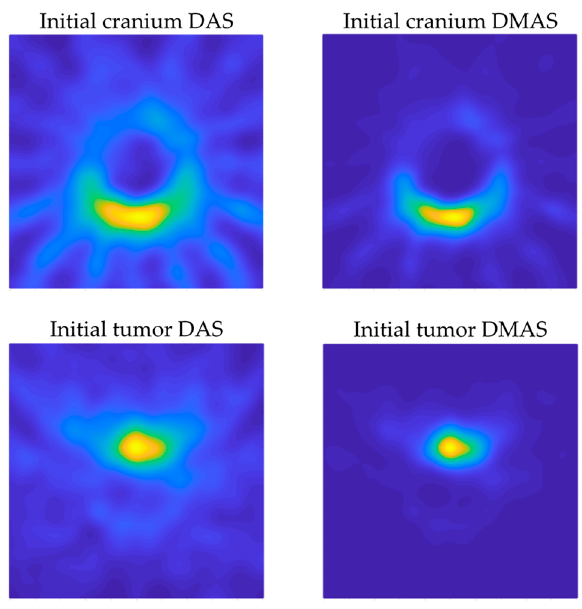
Figure 12. Initial images with DAS and DMAS algorithms.